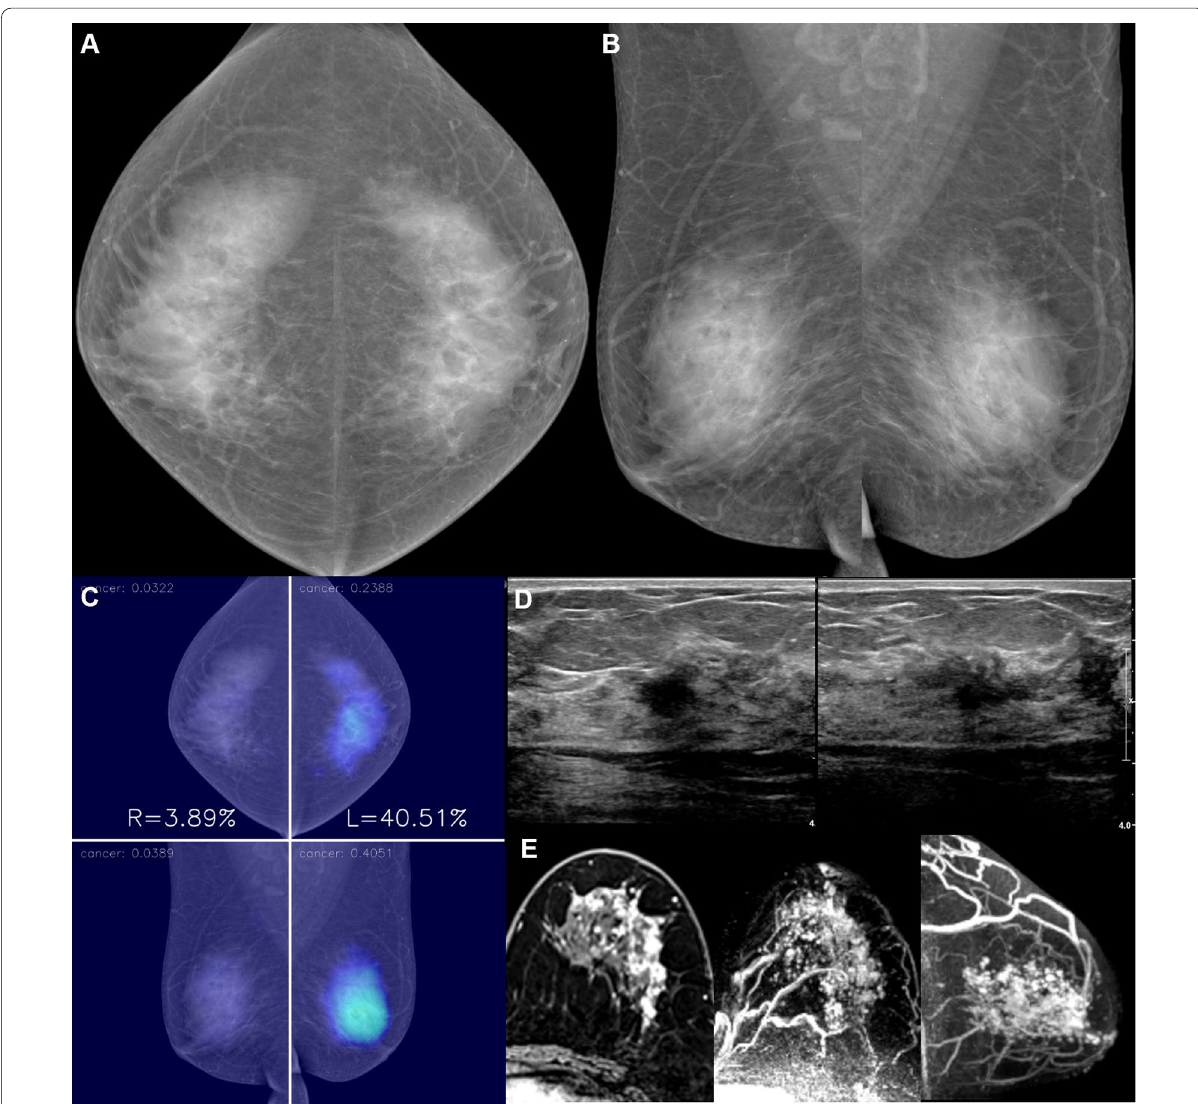
Fig. 6 A 55-year-old woman with invasive lobular carcinoma in the left breast. a , b . No abnormal finding was detected in the mammography of both breasts by a radiologist. c – e AI diffusely highlighted the central portion of the left breast, which correlated with the location of the cancer in US and MRI. The malignancy score of the cancer was 23.9. Surgical histopathologic examination showed a node-positive, low histologic grade invasive lobular carcinoma that was estrogen receptor-positive, progesterone receptor-positive, and human epidermal growth factor receptor-2-negative by left